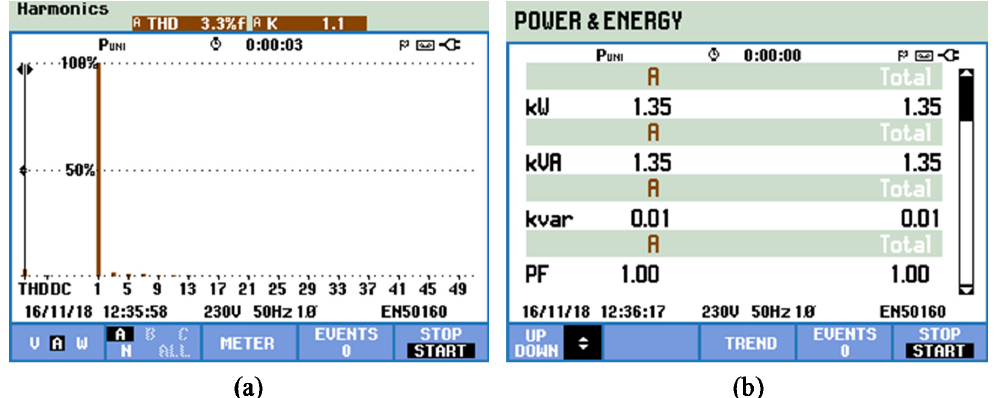
Figure 24. Experimental results during the MF-EVCS operation in R2G mode combined with G2V mode: ( a ) Harmonic spectrum of the total home current ( i g ); ( b ) Operating powers and total power factor.